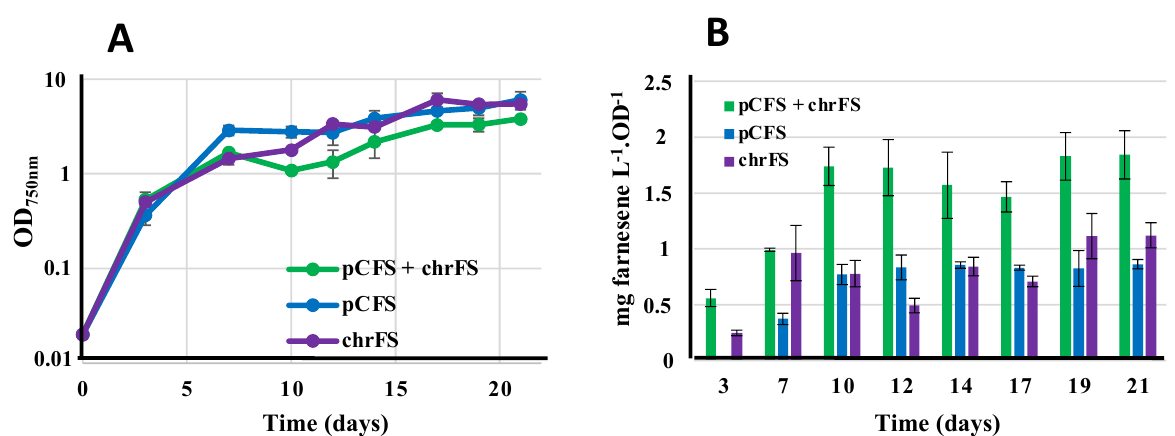
Figure 6. Simultaneous analysis of growth ( A ) and terpene production ( B ) of the Synechococcus elongatus PCC 7942 strains harboring the strongly expressed farnesene synthase gene (FS) in either or both the replative plasmid (pCFS) or a neutral chromosomal site (chrFS). Cells were grown under standard photoautotrophic conditions in the presence of a dodecane overlay (20% vol/vol) to assay terpene production for 21 days. Error bars represent standard deviation from biological triplicates.